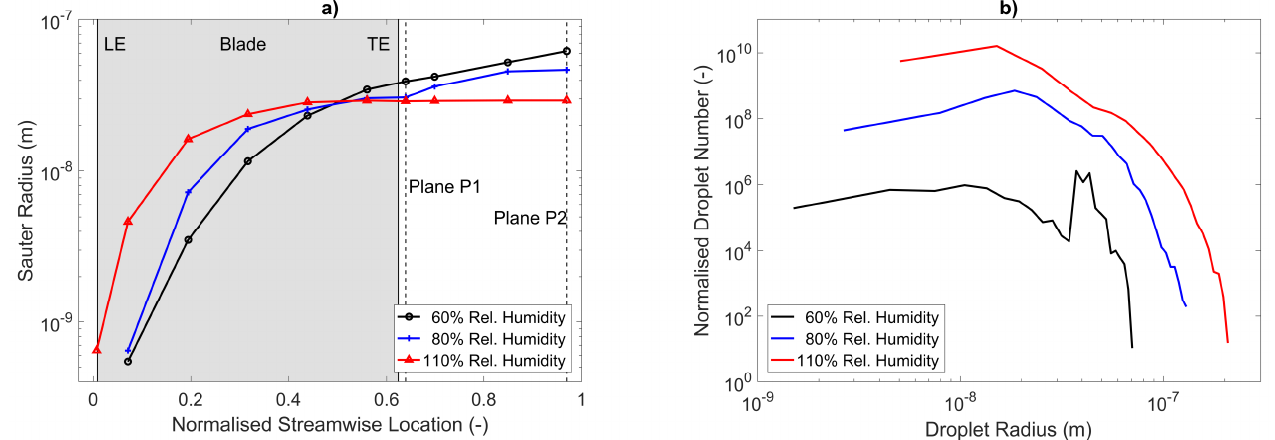
Figure 8. Analysis of the dispersed droplet phase. ( a ) Sauter radius along the rotor flow. ( b ) Droplet spectrum at plane